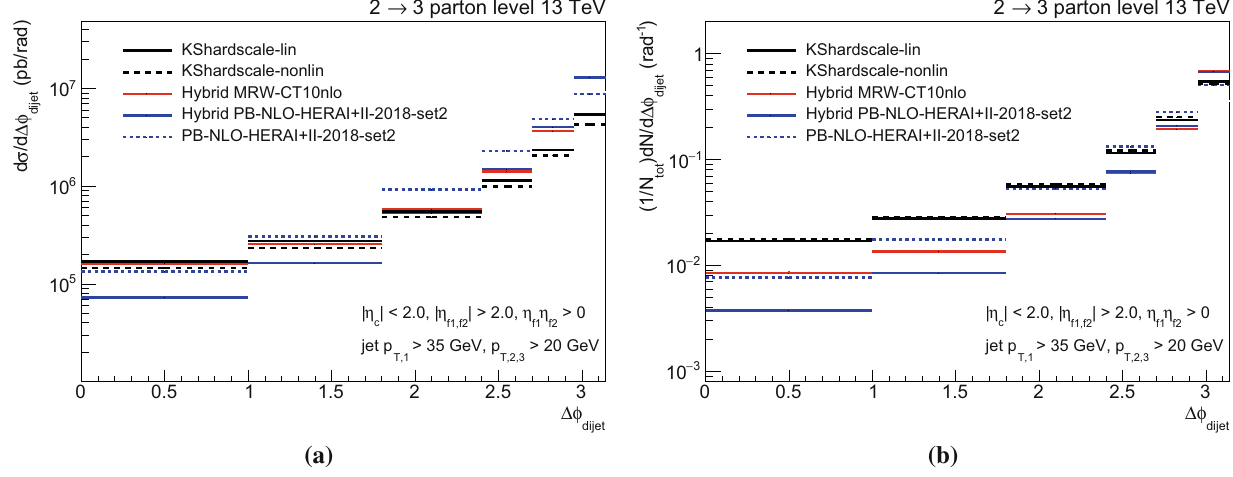
Fig. 2 Comparison of different 2 → 3 parton level predictions using both hybrid and full off-shell calculations. With KS PDFs including Sudakov resummation. Shown in absolute cross sections ( a ) and normalised distributions ( b )